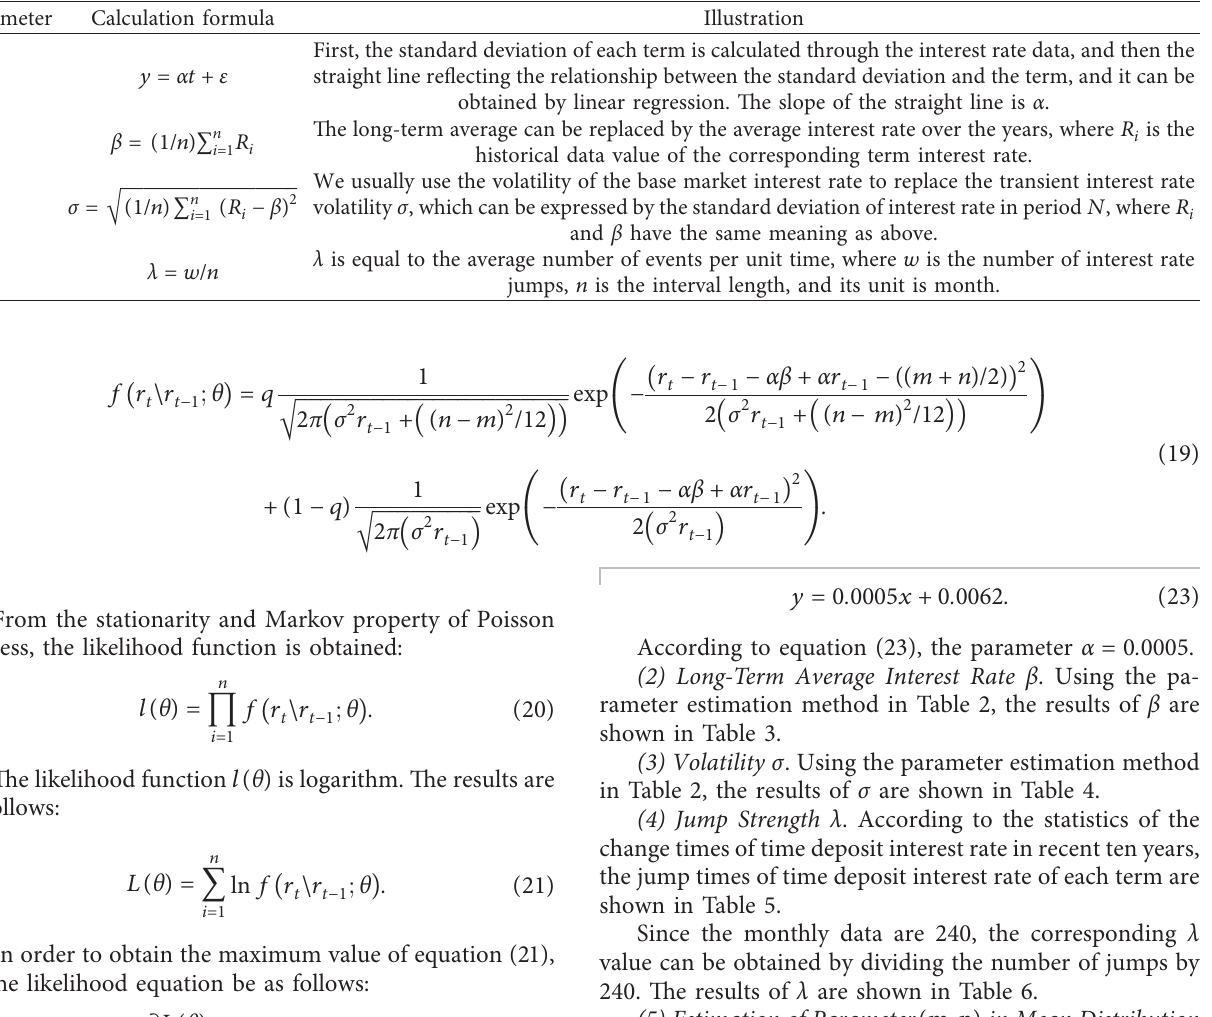
Table 2: Estimation method of basic